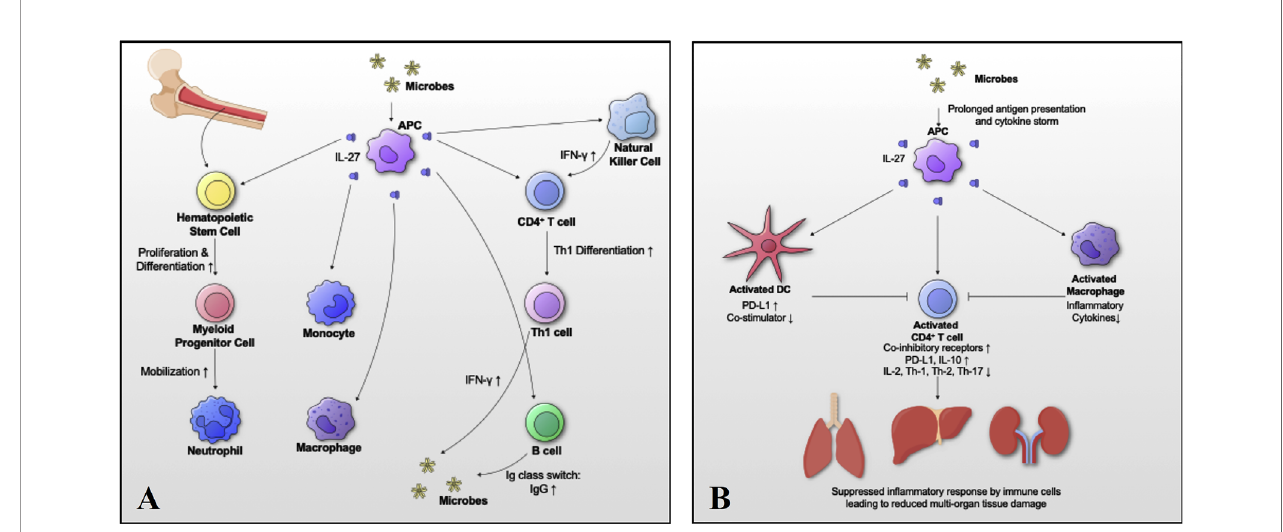
FIGURE 5 | Schematic model of IL-27-mediated immune homeostasis during bacterial infections. To better understand the role of IL-27 signaling in immune responses during bacterial infections, we propose a hypothetical mechanism by which IL-27 regulates activation and return to homeostasis in a time dependent manner. (A) At the onset of infection, IL-27 signaling induces myelopoiesis, differentiation and migration of immune cells with Th1 differentiation and IFN- g production. (B) Following the acute response, IL-27 signaling suppresses immune responses to avoid “ cytokine storm ” and multi-organ failure due to excessive in fl ammation in vital organs. To control excessive in fl ammation IL-27: 1) increases expression of co-inhibitory receptors, 2) decreases co-stimulator expression by activated dendritic cells, 3) suppresses production of in fl ammatory cytokines by activated macrophages and T cells, and 4) promotes production of IL-10 in T cells, all of which suppress in fl ammatory responses by immune cells and avoid internal organ tissue